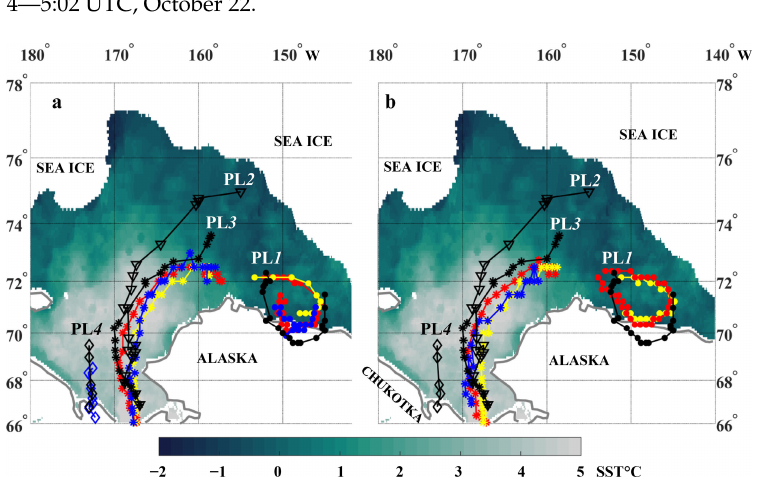
Figure 2. PL 1 (circles), PL 2 (triangles), PL 3 (asterisks) and PL 4 (diamonds) tracks: obtained from satellite measurements (black); derived from ERA5 (red), MERRA-2 (yellow) and CFSv2 (blue) relative vorticity at 850 hPa ( a ) and SLP ( b ) fields. The sea surface temperature field (color) is for 19 October